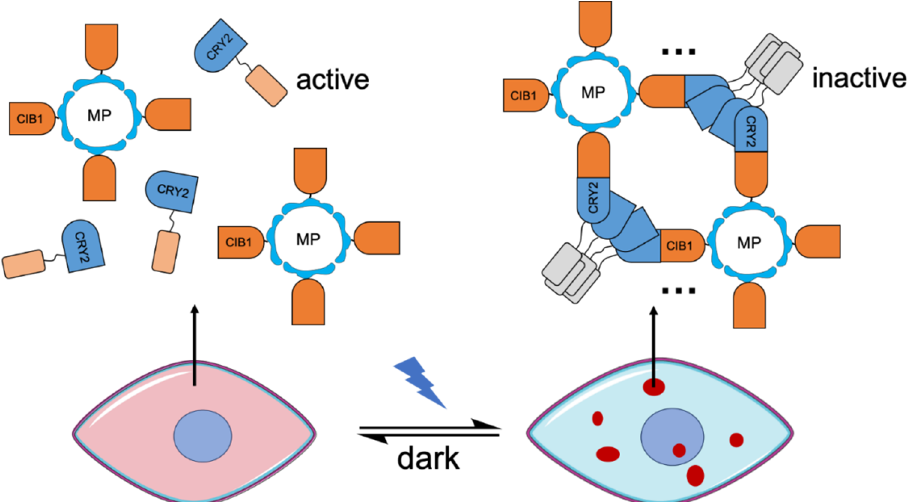
Figure 4. A schematic of the LARIAT (light-activated reversible inhibition by assembled trap) system. Inhibition of biofunctional modules based on a combination of cryptochrome 2 (CRY2) homo-oligomerization and CRY2-CIB heterodimerization. Light-induced clusters are represented in dark-red dots. MP, multimeric protein.